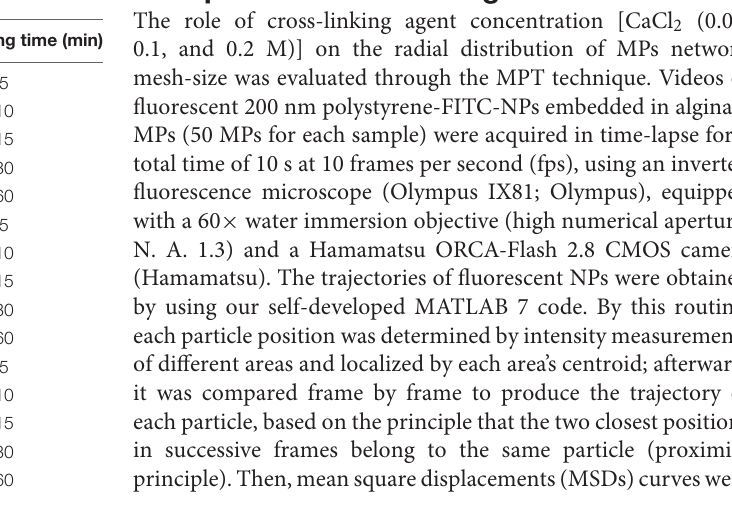
TABLE 1 | Formulation tested in this